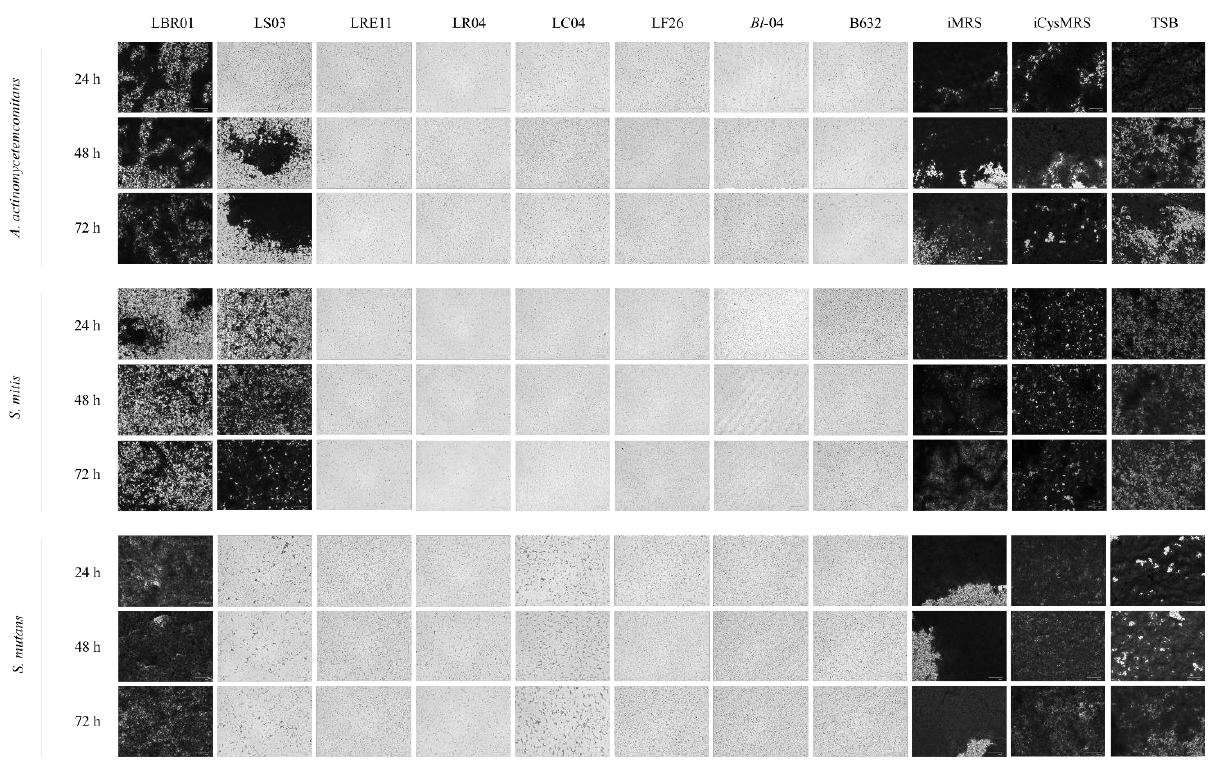
Figure 4. Representative crystal violet-stained biofilm images. Images were obtained at FLoid TM Cell Imaging Station. Magnification 460 ×